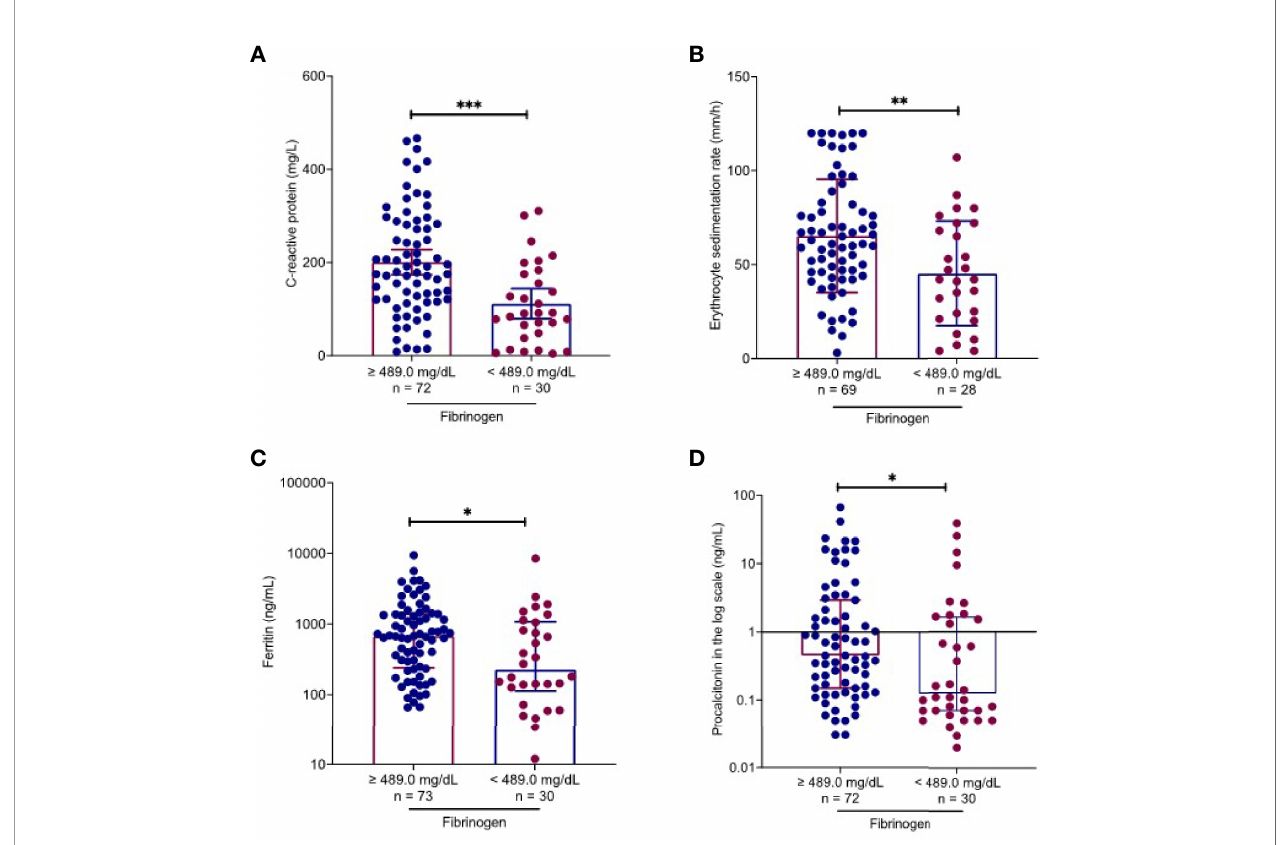
FIGURE 2 | Fibrinogen-associated factors in COVID-19 patients. Using the upper level of the reference laboratory 489.0 mg/dl, in fl ammatory markers were compared between patients with normal and elevated fi brinogen levels. Patients with elevated fi brinogen levels had higher C-reactive protein (A) , erythrocyte sedimentation rate (B) , ferritin (C) and procalcitonin (D) levels than those with normal fi brinogen levels. All data points are shown, and medians ± interquartile range are shown by horizontal bars. Mann-Whitney U test was performed to determine the statistical signi fi cance. Here, *, ** and *** indicate a P value < 0.05, 0.005 and 0.001, respectively.